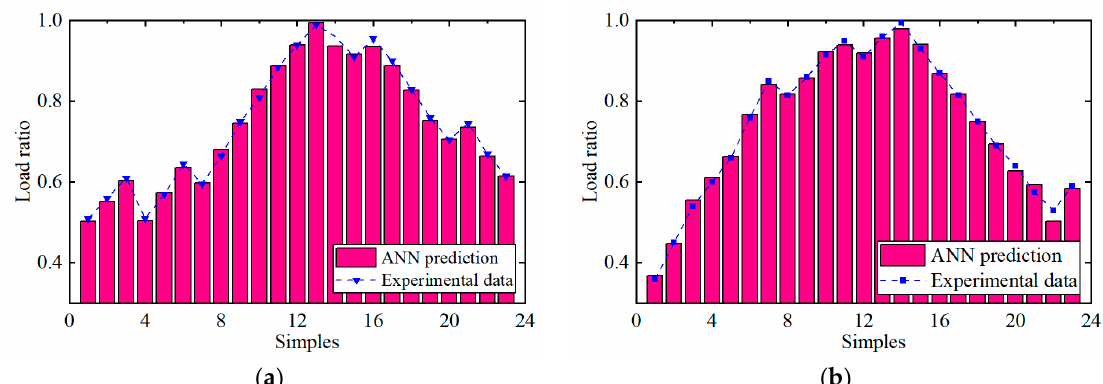
Figure 20. Comparison of modified ANN predictions and experimental data with PSO; ( a ) the first stage; ( b ) the second stage.